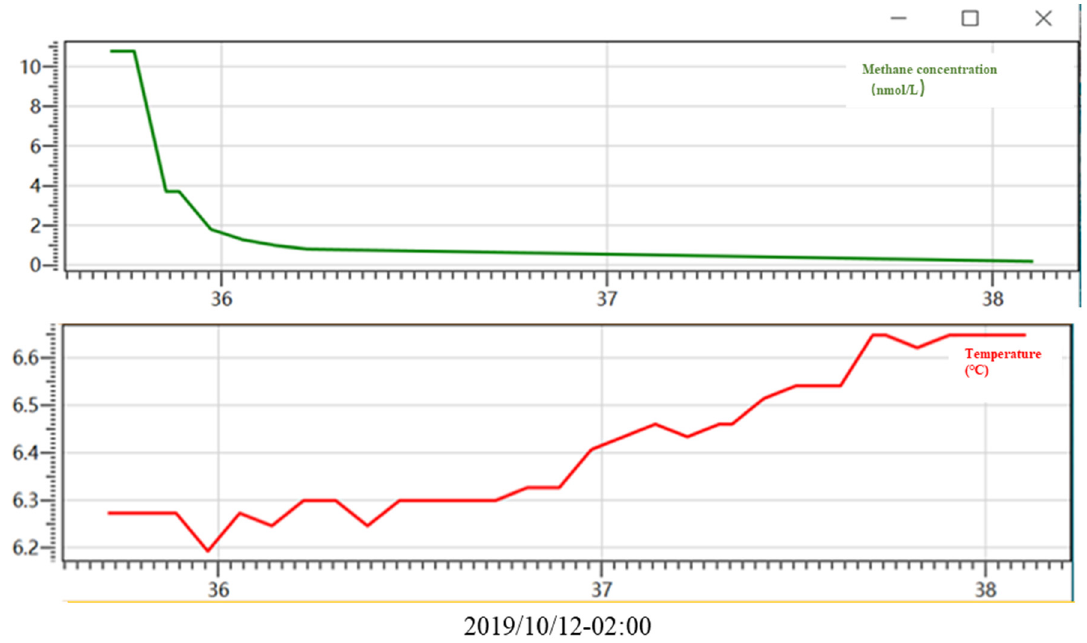
Figure 6. Test data at a water depth of 500 m (18,264–18,187 sound communication module paired successfully).